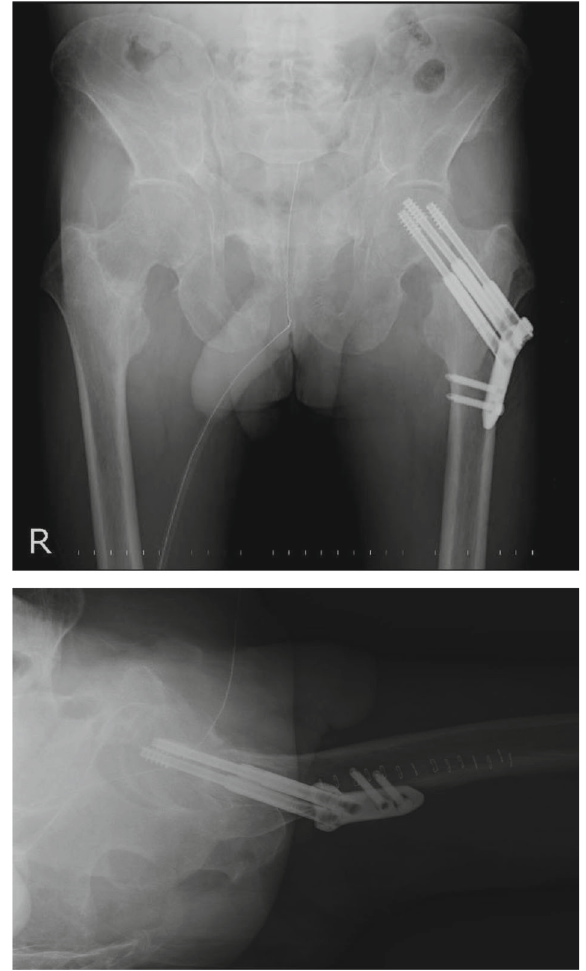
Figure 5: Radiographs taken immediately after surgery. The fracture was fi xed using an implant with multiple compression hip screws and a side